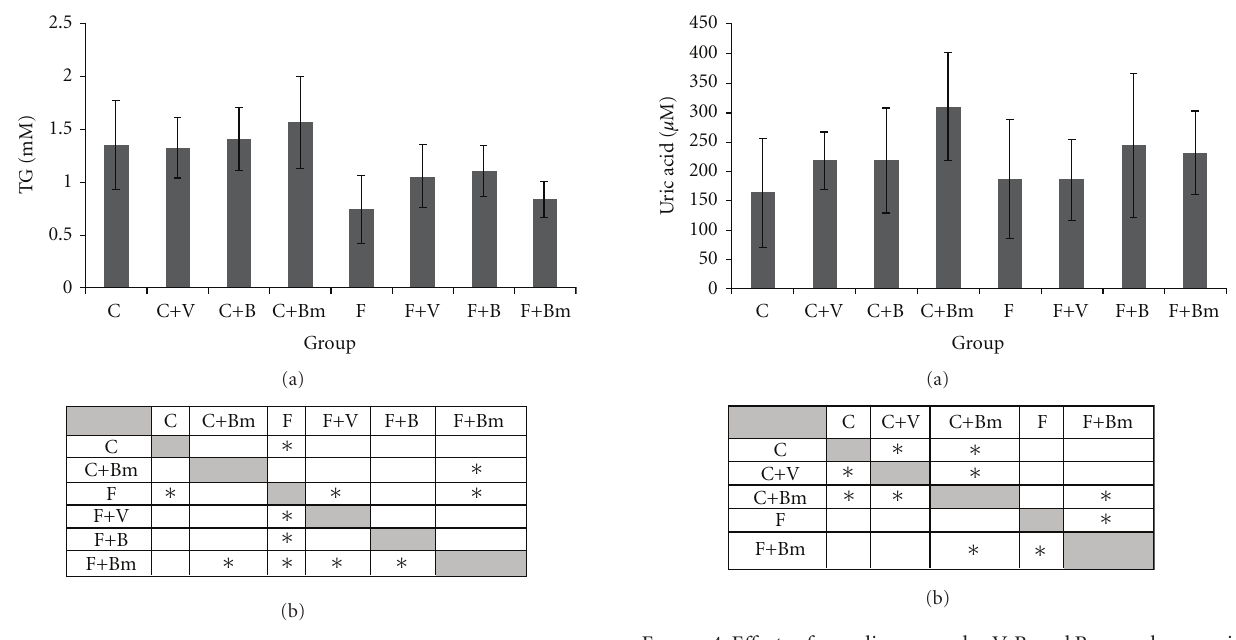
Figure 3: E ff ects of vanadium complex V, B, and Bm on plasma triglycerides (TG) of Wistar rats. Data are presented as mean ± SD.